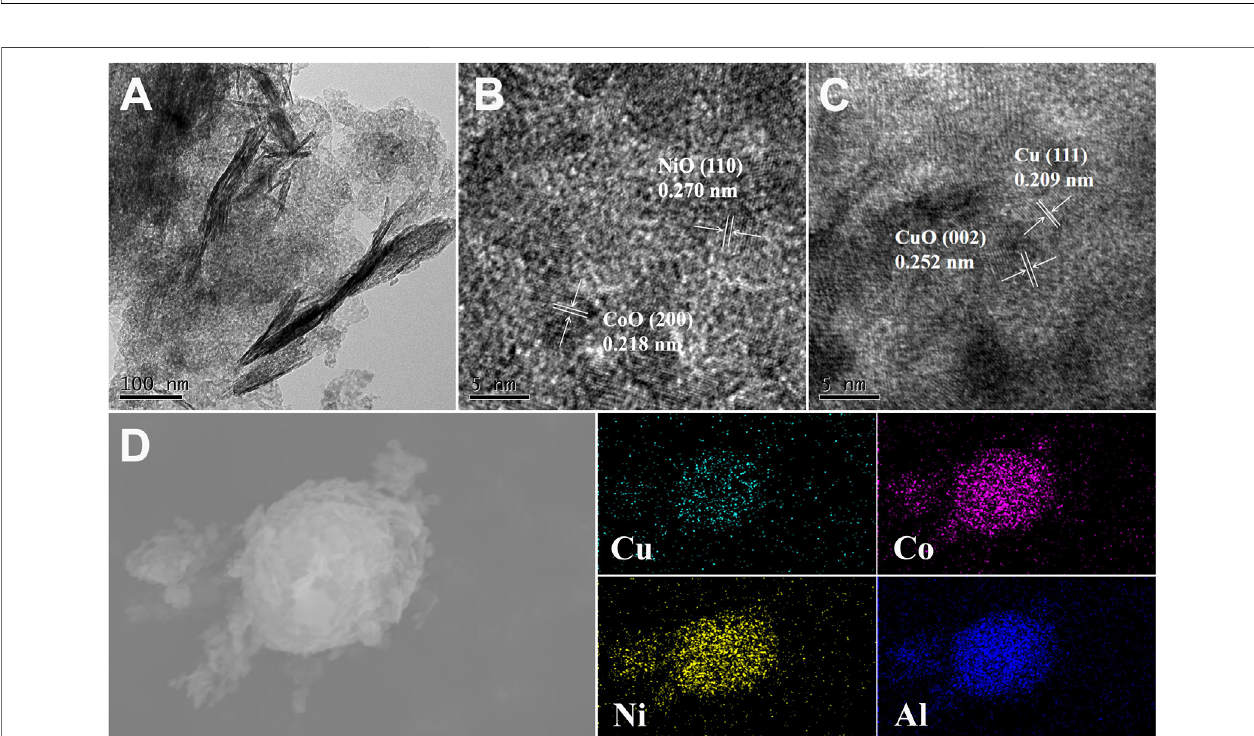
FIGURE 3 | (A) TEM and (B) , (C) HRTEM images of CuCoNiAl-MMO, (D) SEM-EDS image and corresponding element maps for CuCoNiAl-MMO.